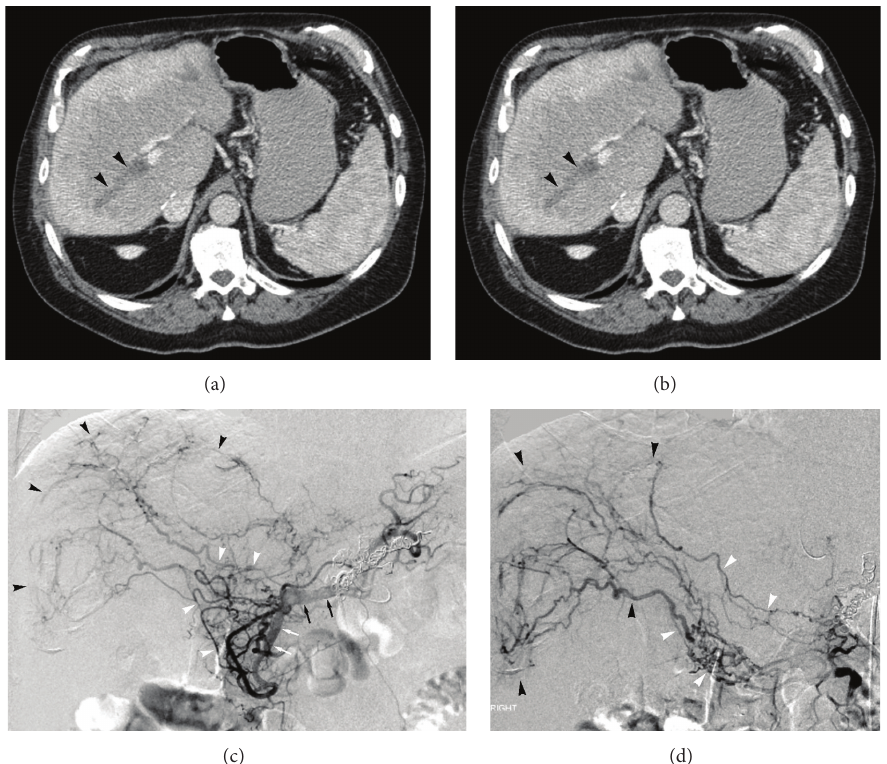
Figure 2: Axial contrast enhanced CT scan image (a) reveals right-sided intrahepatic portal vein thrombosis (arrowheads). Thrombus (arrowhead) extends into main portal vein on more caudal image (b). Subtracted common hepatic arteriogram (a) demonstrates chronic proper hepatic artery occlusion with transplant liver perfusion (black arrowheads) via mature pancreaticoduodenal collateral vessels (white arrowheads). Black and white arrows delineate common hepatic artery and gastroduodenal artery, respectively. Selective gastroduodenal arteriogram (b) better demonstrates mature pancreaticoduodenal collateral vessels (white arrowheads), which result in transplant liver perfusion (black